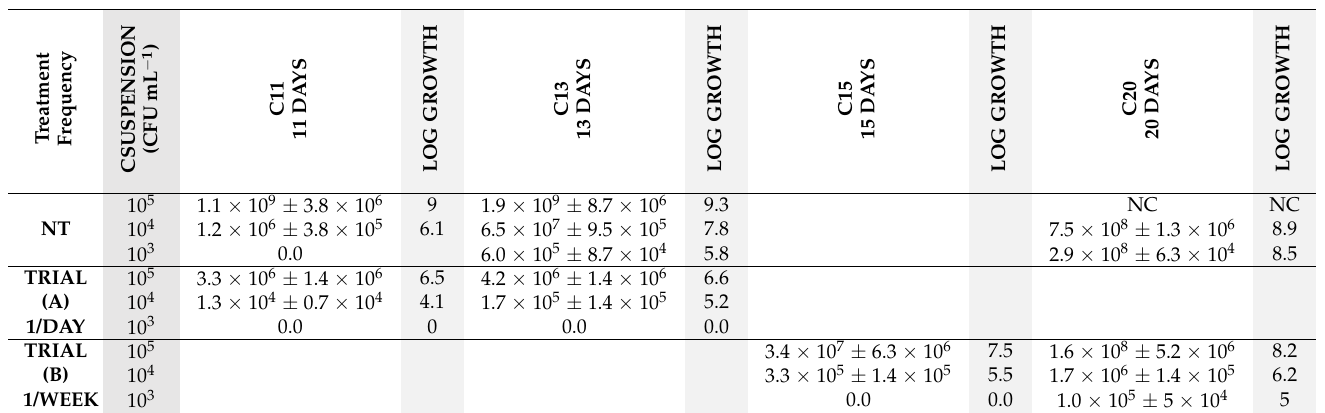
Table 2. Results of the dose dependence experiment performed on BYCE agar surface-grown XfDD.